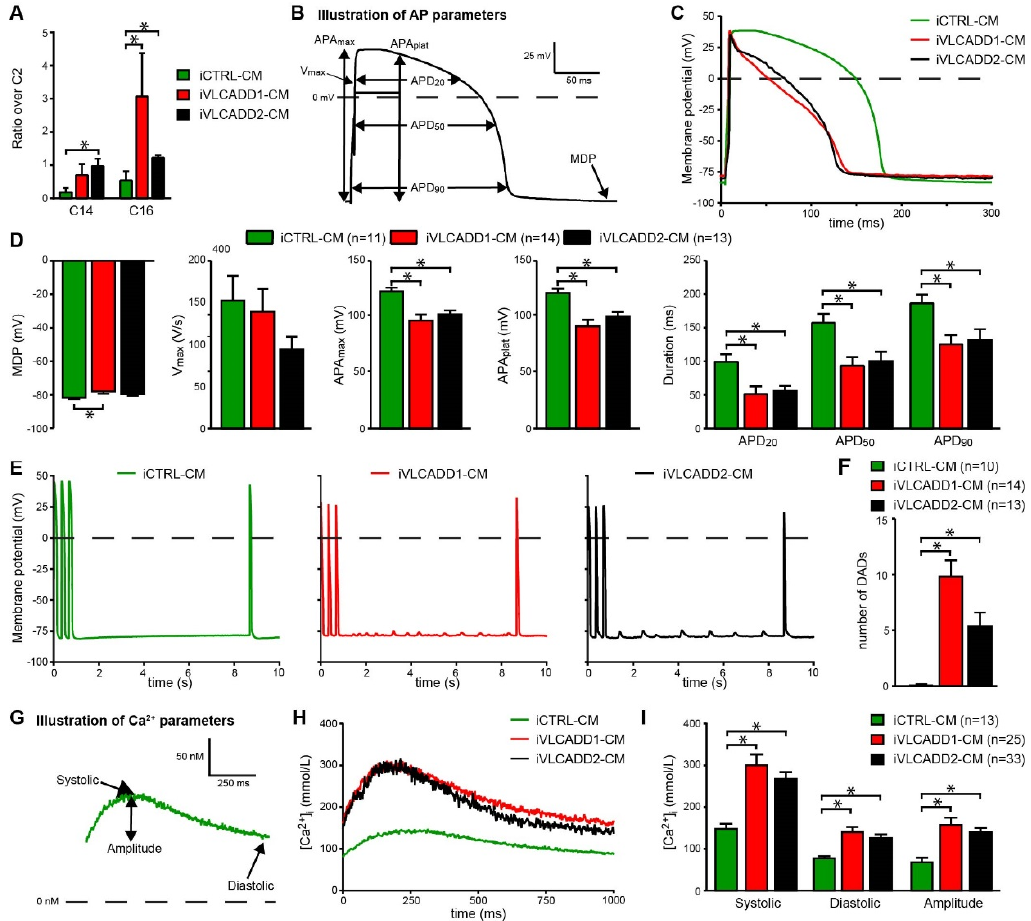
Figure 1. Electrophysiological abnormalities in very long-chain acyl-CoA dehydrogenase deficiency (VLCADD) human induced pluripotent stem cell- cardiomyocytes (hiPSC-CMs). ( A ) Increased C14 / C2 carnitine and C16 / C2 carnitine ratio in medium of iVLCADD1-CMs and iVLCADD2-CMs compared to control cardiomyocytes (iCTRL-CM) after 96 h culturing with palmitate loading. Data expressed as mean + SD ( n = 3). Statistical analysis was performed using a two-way ANOVA with Sidaks multiple comparisons test. * = p < 0.05. ( B ) Analyzed action potential (AP) parameters. ( C ) Representative APs paced at 1 Hz. ( D ) Average AP parameters. ( E ) Typical delayed afterdepolarizations (DADs) measured during an 8 s pause after fast pacing (3 Hz). After this pause, a single AP was evoked to confirm that no early afterdepolarizations occurred. ( F ) Average number of DADs. Electrophysiology data are expressed as mean + SEM of individual measured cells ( n = 11–13). ( G ) Analyzed parameters in Ca 2 + transients. ( H ) Representative Ca 2 + transients of Indo-1 loaded hiPSC-CMs paced at 1 Hz. ( I ) Average [Ca 2 + ]i (mean + SEM) * = p < 0.05. Statistical analysis was assessed with one-way ANOVA with Tukey’s multiple comparisons test. 2.5. VLCADD-CMs Show Increased Ca 2+ Concentration Using fluorescence measurements, we characterized various Ca 2+ transient parameters (Figure 1G) and found a higher systolic and diastolic intracellular Ca 2+ concentration ([Ca 2+ ] i ) as well as an increased transient amplitude in iVLCADD1-CMs and iVLCADD2-CMs compared to iCTRL-CMs (Figure 1H–I). Collectively, these results demonstrate that hiPSC-CMs from VLCADD patients exhibit increased LCAC accumulation and that [Ca 2+ ] i is increased, accompanied by AP shortening and presence of DADs.